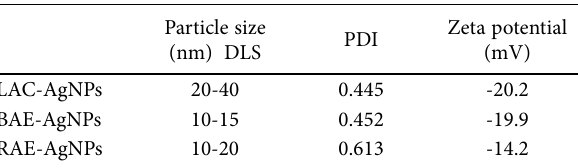
Table 3. The particle size of silver nanoparticles, polydispersity index and Zeta